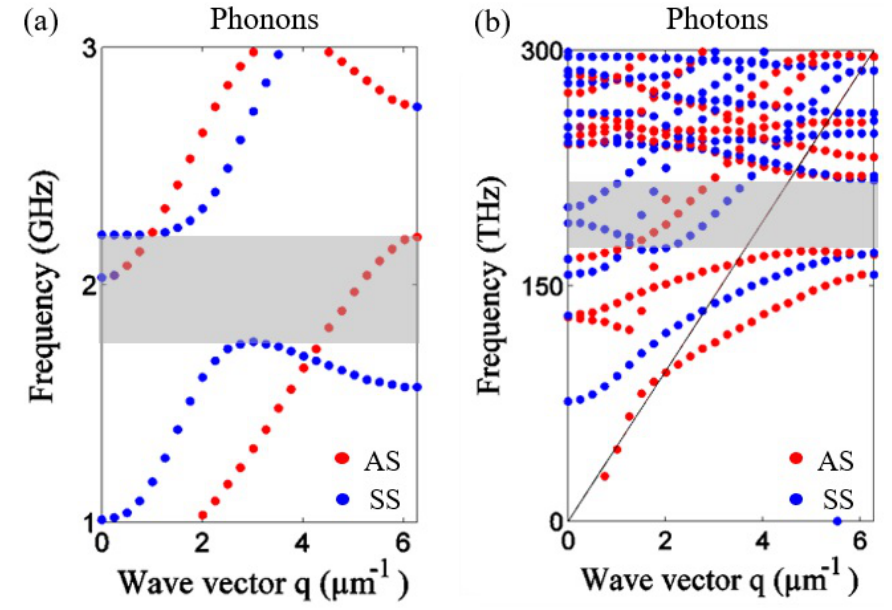
Figure 12. ( a ) Phononic and ( b ) photonic dispersion curves. The red and blue branches respectively correspond to the Anti-symmetric (A) and Symmetric (S) modes with respect to the xOz plane. All the considered branches are Symmetric (S) with respect to the xOy plane. The shaded area corresponds to the bandgaps. The straight line in panel ( b ) is the light line in